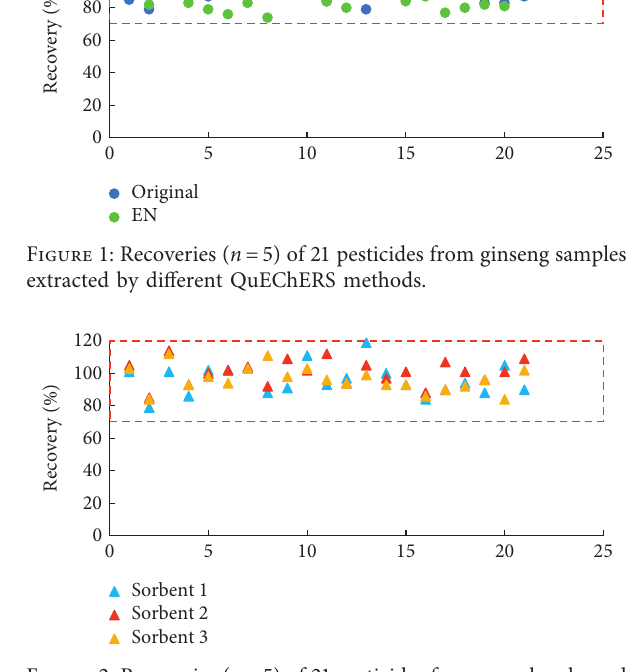
Figure 2: Recoveries ( n � 5) of 21 pesticides from samples cleaned up by different sorbents (sorbent 1, 50 mg PSA+50mg C 18 ; sorbent 2, 50mg PSA+50 mg FLS; and sorbent 3, 50mg PSA+ 50mg Z- Sep).